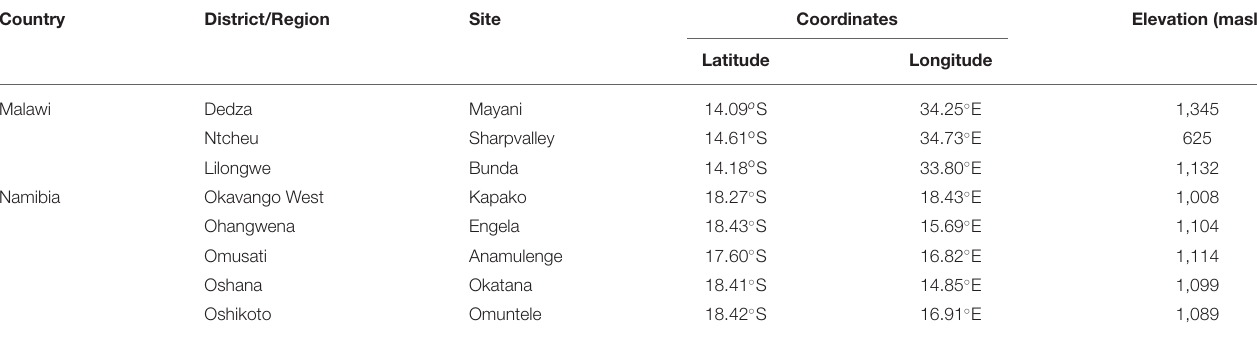
TABLE 1 | Geographic location of the three districts of central Malawi and the five regions of northern Namibia where the study was conducted.